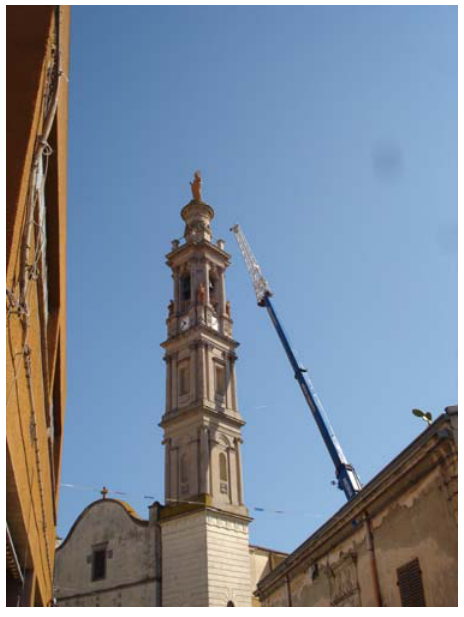
Fig. 13: Laser scanner survey of the Bell Tower